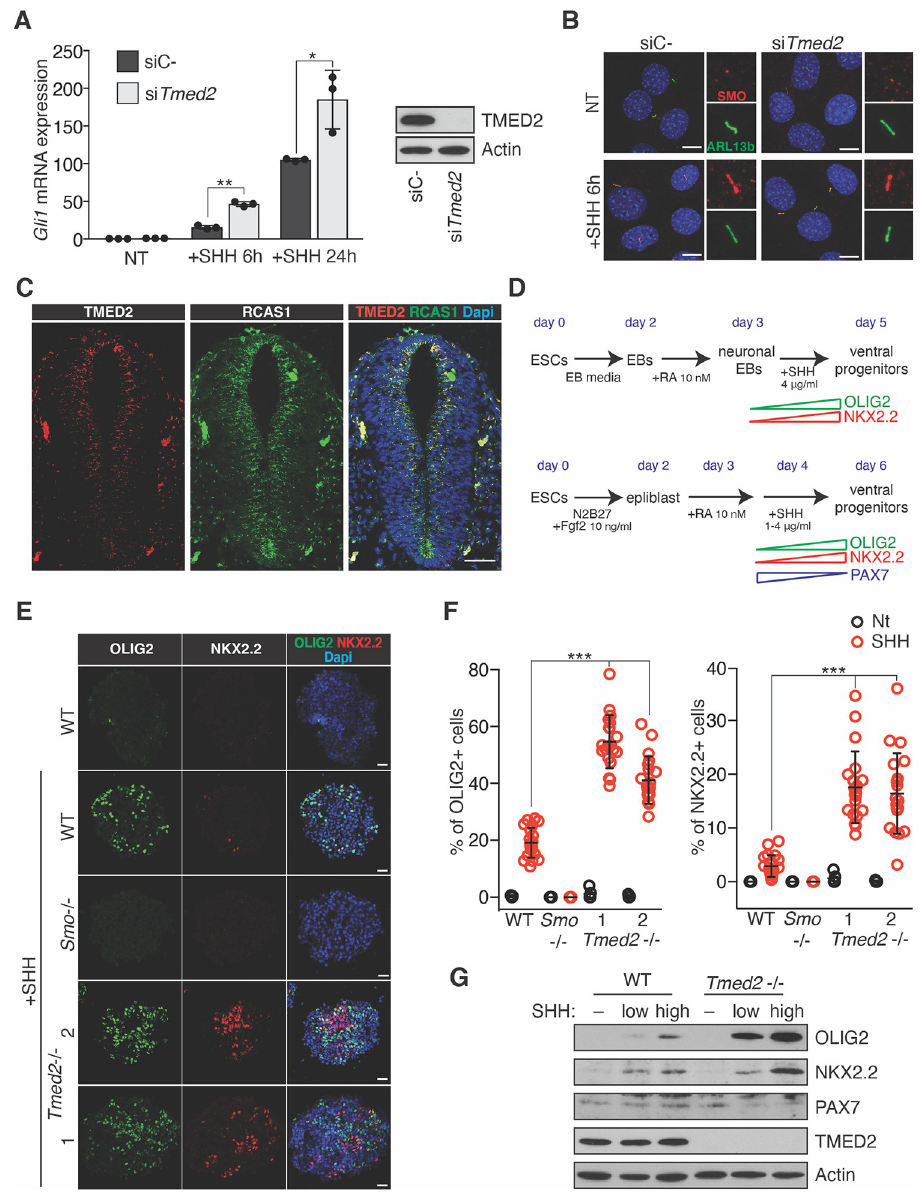
Fig 4. TMED2 is a negative regulator of HH signaling in neural differentiation. (A, B) Tmed2 knockdown promotes GLI activity after SHH treatment in NIH-3T3 cells. NIH-3T3 cells were transfected with an siRNA targeting Tmed2 (si Tmed2 ) or a nontargeting control (siC-) and treated with SHH for 6 and 24 hours. (A) RT-qPCR of Gli1 mRNA. Asterisks denote statistical significance for difference between indicated samples. On the left, immunoblot showing siRNA knockdown efficiency of TMED2. Actin is shown as a loading control. (B) Immunofluorescence staining of SMO (red) and ARL13B (green) to visualize primary cilia after 6 hours of SHH treatment. Scale bar = 10 μ m. Inserts (right) magnify SMO and ARL13B localization at the primary cilium. (C) Immunostaining of TMED2 (red) and the Golgi marker RCAS1 (green) in neural tube sections of WT E9.5 mouse embryos. Scale bar = 50 μ m. (D–G) Tmed2 mutation increases SHH-dependent ventral marker expression in NPCs. (D) Schematic overview of the protocol for deriving neuralized EBs from ESCs (top) and of the NPC adherent culture differentiation (AD) protocol (bottom). The expected timing of NPC marker expression is indicated. (E) Representative immunofluorescence images of ventral markers OLIG2, and NKX2.2 in neuralized EBs of indicated genotypes treated with or without SHH. Scale bar = 25 μ m. Asterisks denote statistical significance for difference between indicated samples. (F) Percentage of cells expressing OLIG2 (left) and NKX2.2 (right) relative to total cell count in neuralized EBs as in C. Individual EBs are plotted ( n = 20). (G) Western analysis of ventral markers OLIG2 and NKX2.2 and the dorsal marker PAX7 in WT and Tmed2 −/− NPCs on day 5. The data underlying all the graphs shown in the figure